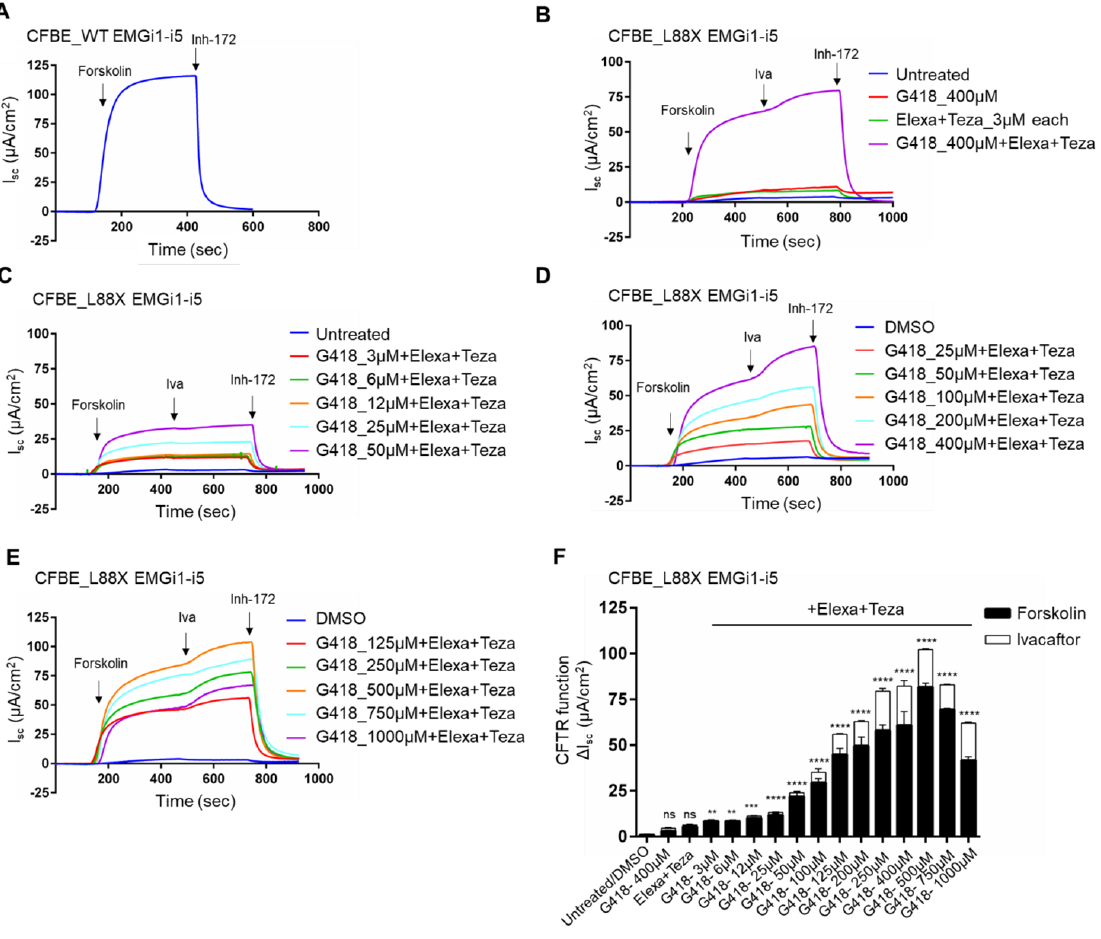
Figure 3. Combination treatment of readthrough G418 with CFTR modulators restores L88X CFTR function in a dose dependent manner in CFBE stable cells. ( A ) A representative short circuit current (Isc) assay in CFBE cells stably expressing WT- CFTR- EMGi1-5 grown on snapwells. CFBE cells were mounted on Ussing chambers to measure CFTR mediated chloride activity as a proxy to CFTR function. Forskolin (10 µM) was added to the basolateral chamber, followed by CFTR inhibitor Inh- 172 (10 µM) added to the apical chamber. Average CFTR function for all WT- CFTR- EMGi1-5 CFBE stable cells was 123 ± 11 µA/cm 2 . ( B – E ) Isc assay of CFTR channel function in CFBE cells stably expressing L88X- CFTR -EMGi1-i5. Cells were incubated for 24 h with varying concentrations of readthrough compound G418 (3 µM – 1000 µM), CFTR correctors elexacaftor (3 µM) and tezacaftor (3 µM), or both. Forskolin (10 µM) was added to the basolateral chamber, followed by potentiator ivacaftor (10 µM), and CFTR inhibitor Inh-172 (10 µM) added to the apical chamber. ( F ) Stacked bar plots indicate effect of G418 readthrough concentration and modulator treatment on L88X- CFTR - EMGi1- i5 CFBE cells. Change in Isc (ΔIsc) was defined as the current inhibited by Inh -172 after sustained Isc responses achieved upon stimulation with forskolin alone or sequentially with ivacaftor. ** indicates p ≤ 0.01, *** indicates p ≤ 0.001, **** indicates p ≤ 0.0001. 3.4. ELX-02 Readthrough and Modulator Treatment of L88X Results in Dose-Dependent Recovery of CFTR Function Given the known toxicity of G418, there remains the limitation that the concentration necessary to observe substantial CFTR function recovery may be above a reasonable